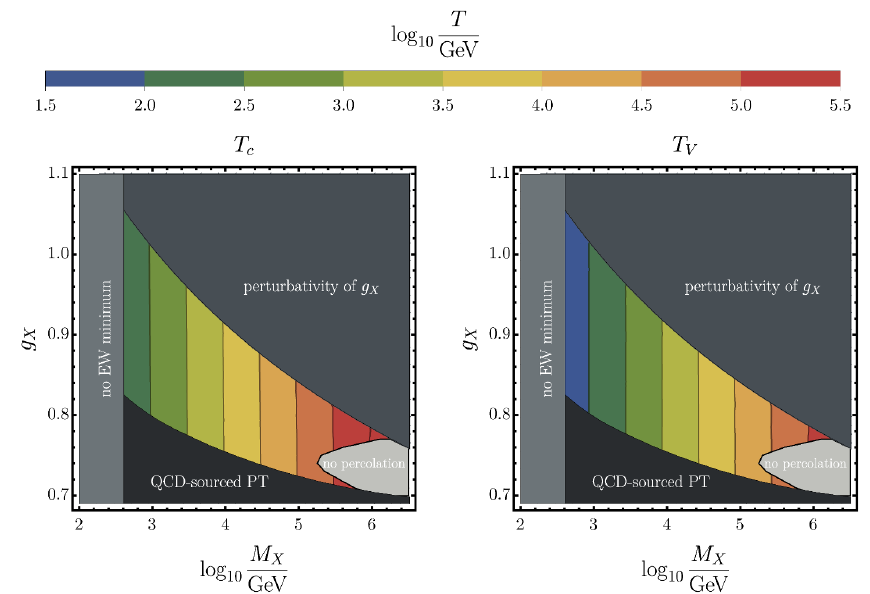
Figure 6 . The values of the critical temperature T c (left panel) and the temperature at which thermal inflation starts T (right V